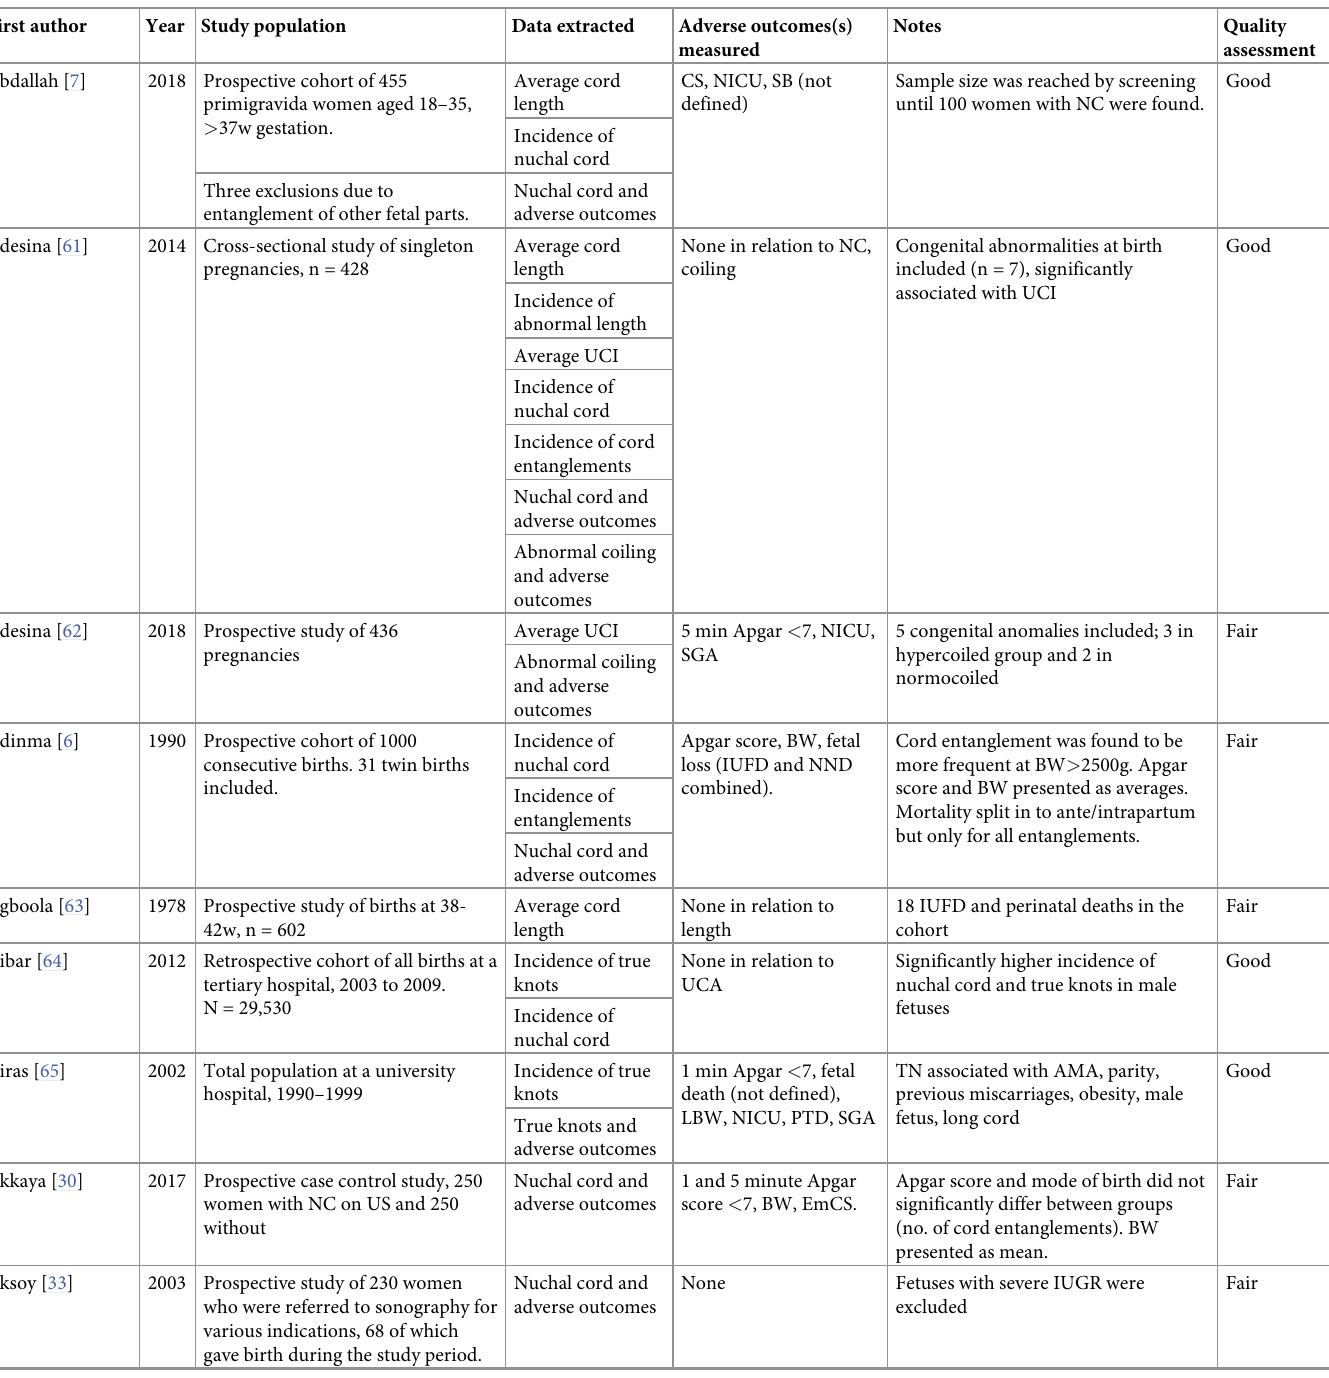
Table 1. Characteristics of included